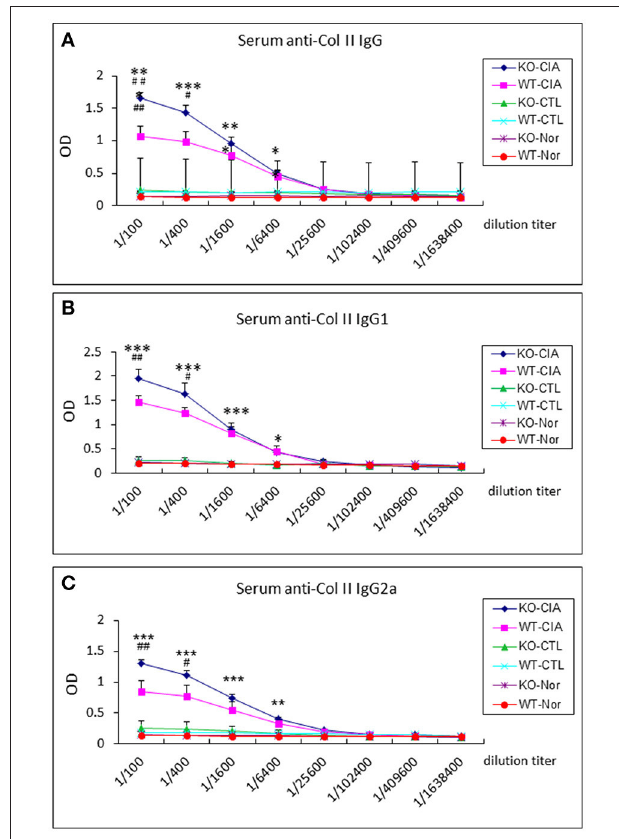
FIGURE 8 | Deletion of Smad7 increases serum levels of anti-collagen II IgG subtypes in CIA mice by ELISA. Note that deletion of Smad7 significantly increases serum levels of anti-collagen II total IgG (A) , IgG1 (Th2, (B) ) and IgG2a (Th1, (C) ) in CIA mice (CD-1). Data represent mean ± S.E. for groups of 8 mice. *p < 0.05, ** p < 0.01, *** p < 0.001 compared to control; # p < 0.05, ## p < 0.01 compared to CIA-WT